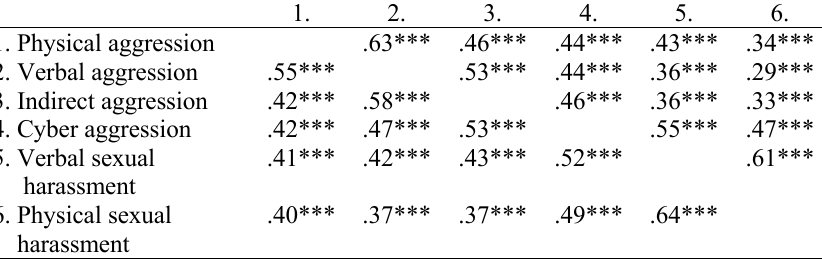
Correlation Coefficients for Victimization below the Diagonal, and for Perpetration above the Diagonal